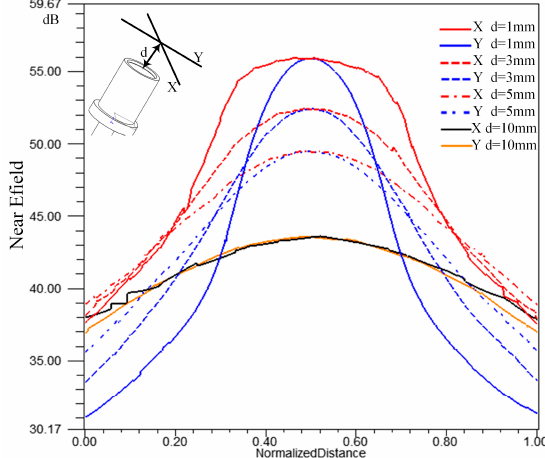
Figure 5. Electric field strengths along the two directions at different distances.